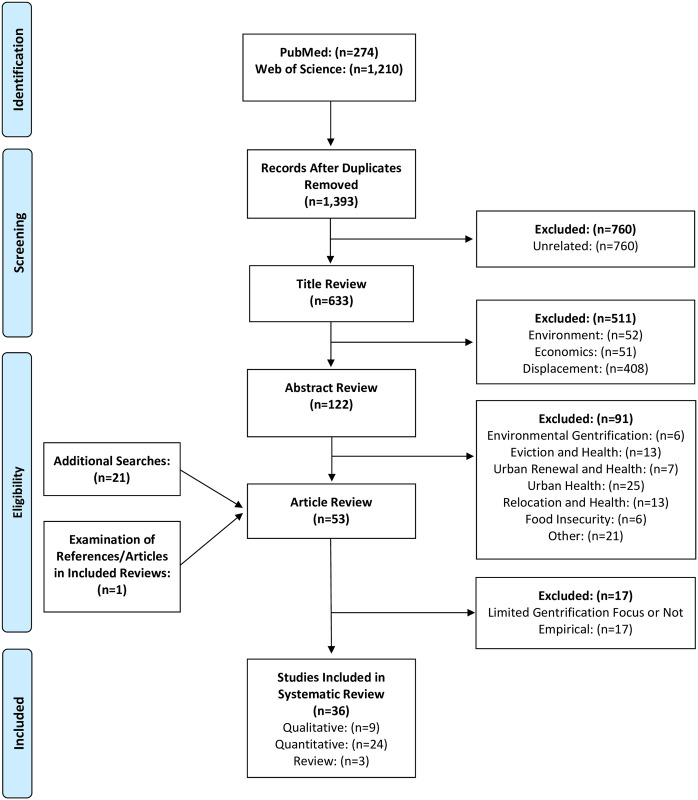
PRISMA flowchart.